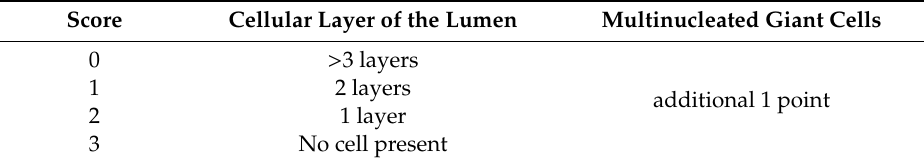
Table 1. Testicular damage scoring criteria. A self-defined testis damage scoring system was used to access the level of testicular damage. The scoring was based on the presence of di ff erent layers of testicular spermatogenic cells in the seminiferous tubules. The score was given reciprocally to the layers of spermatogenic cells. An additional point was assigned when multinucleated giant cells were observed in the lumen of the seminiferous tubules. Score Cellular Layer of the